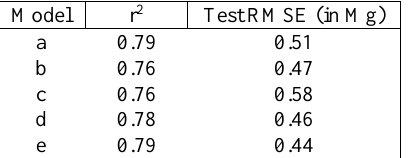
Figure 11. Observed versus predicted using model e